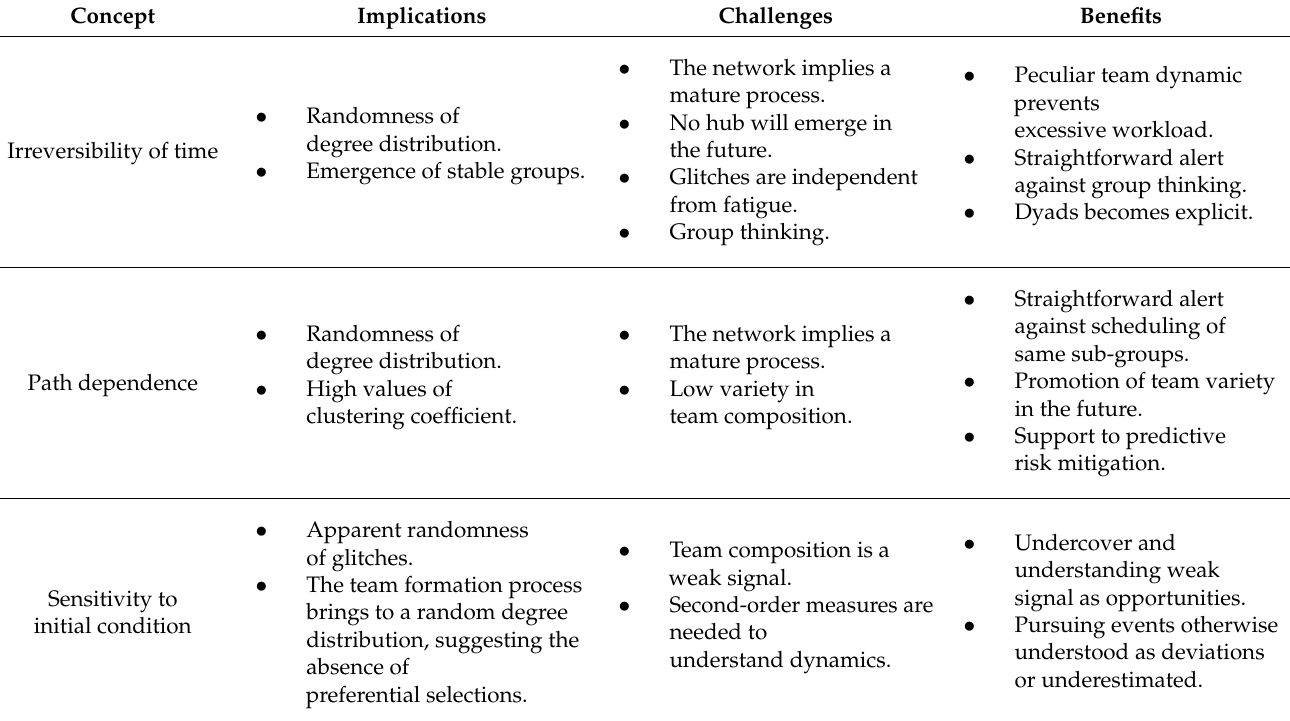
Table 2. Summary of the implications, challenges, and benefits of network science application for teamwork in the case